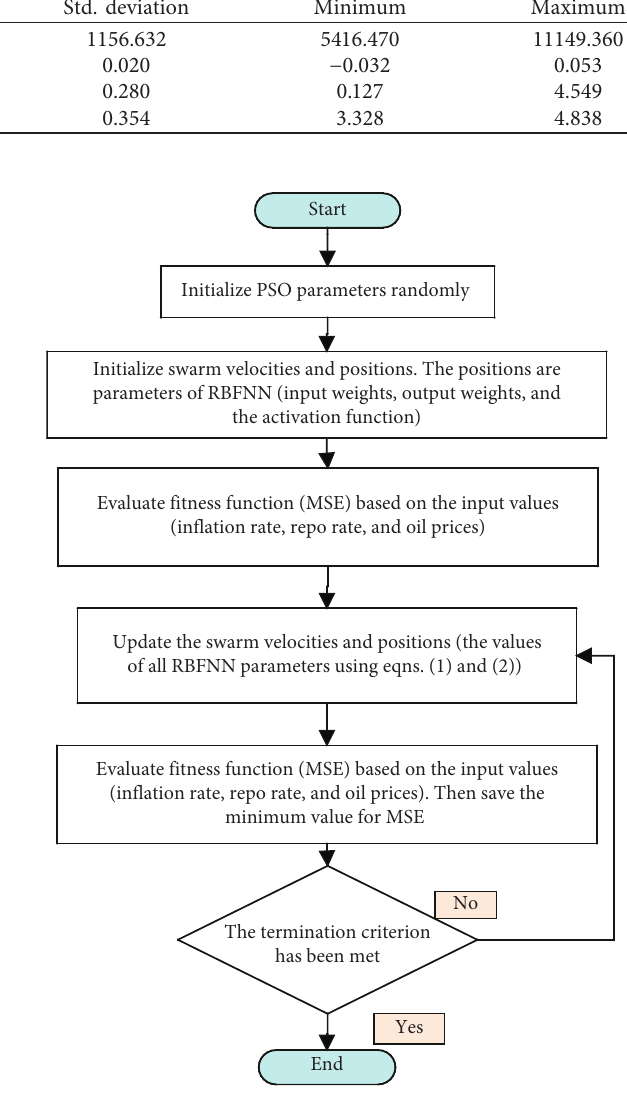
Figure 2: The procedure of the PSO algorithm used for training